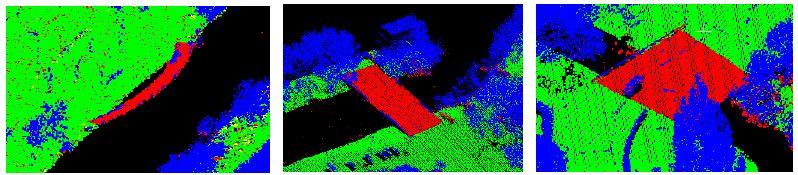
Figure 13. Errors on flat bridges. Red points are those incorrectly labeled as ground points.